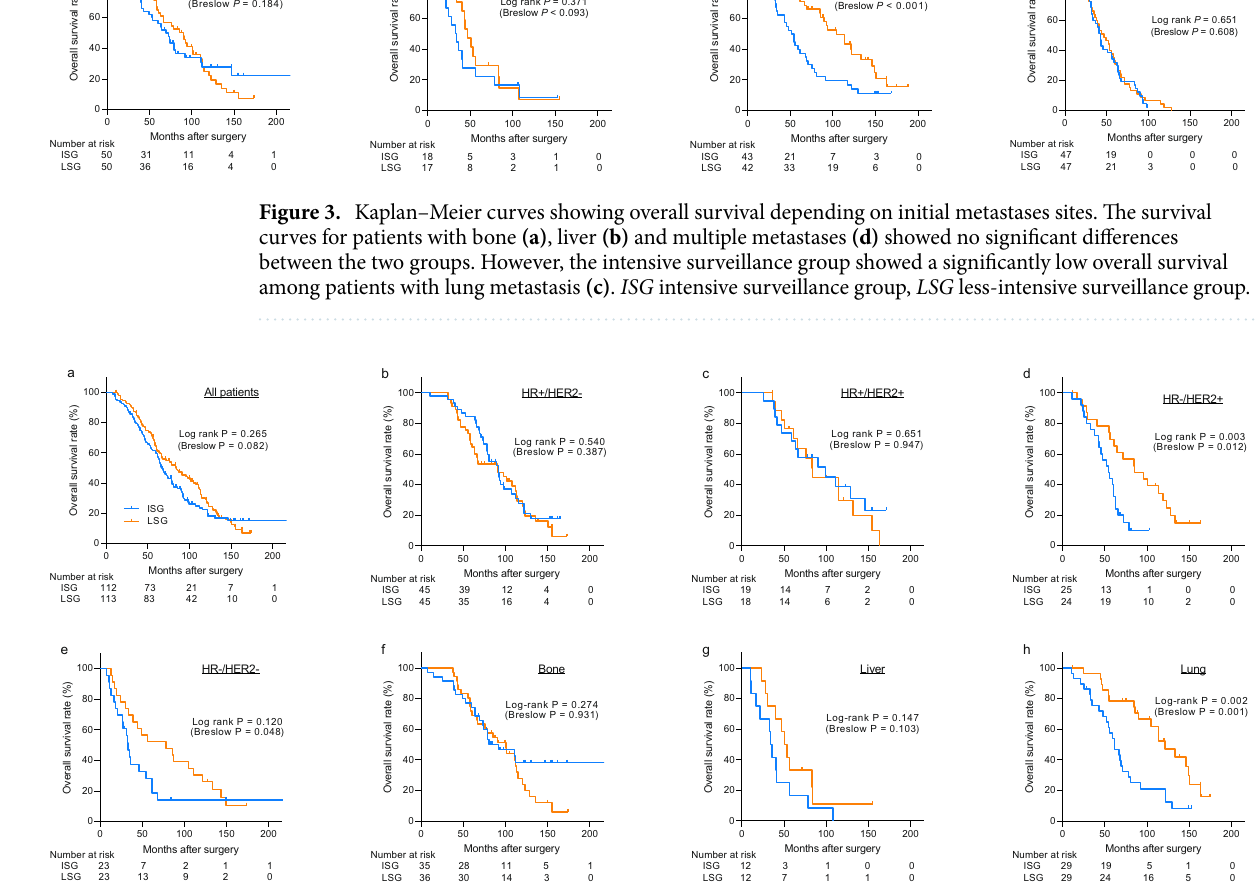
Figure 4. Kaplan–Meier curves showing overall survival of asymptomatic patients and subgroups. The Kaplan–Meier curves show the overall survival of 225 asymptomatic patients. Overall survival was analyzed after dividing the patients into the intensive surveillance group and less-intensive surveillance group (a) . Further subgroup analysis was performed according to subtypes (b–e) and sites of metastases (f–h) . Among asymptomatic patients, 3 patients were unable to obtain the data of subtypes. ISG intensive surveillance group, LSG less-intensive surveillance group, HR hormone receptor, HER2 human epidermal growth factor receptor type